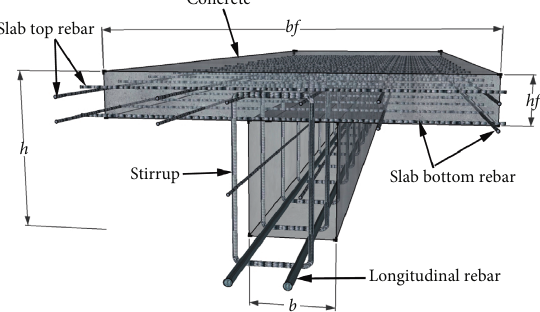
Table 8: The cost of different beams.